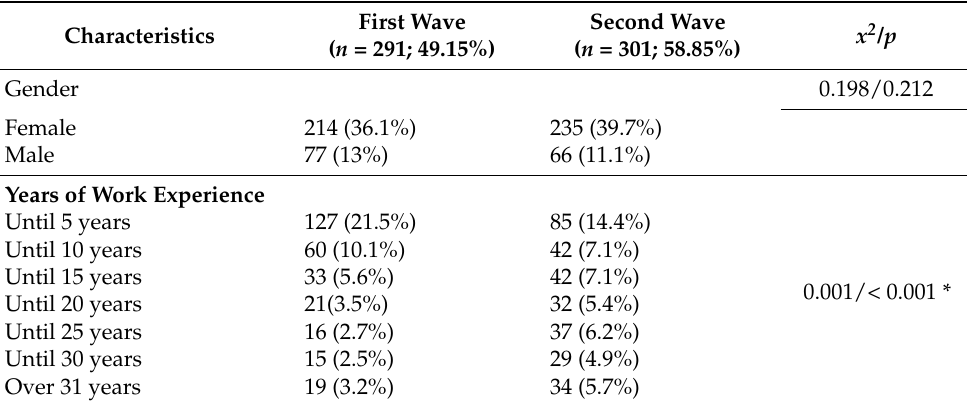
Table 1. Socio-demographic characteristics in nurses during the first and the second wave of the COVID-19 pandemic ( n = 592). First Wave Second Wave Characteristics ( n = 291; 49.15%) ( n = 301; 58.85%)